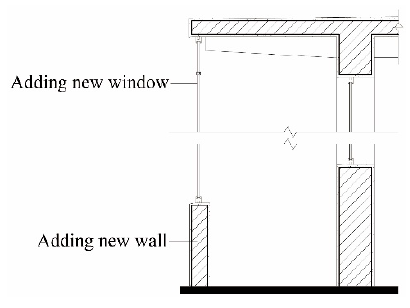
Figure 27. Attached sunspace.